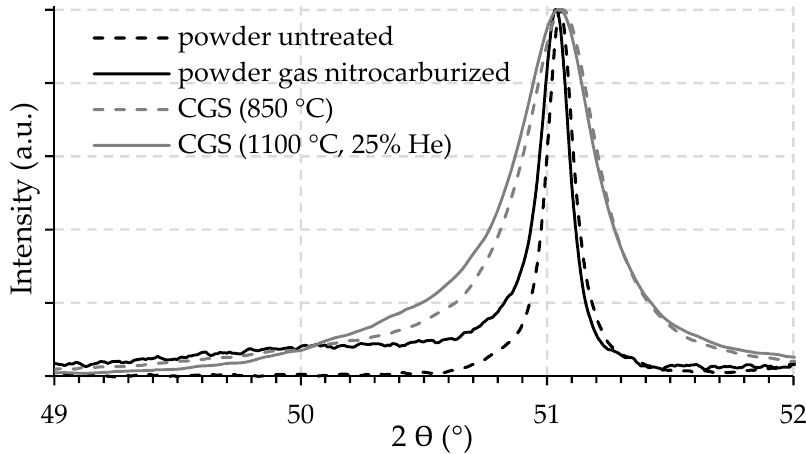
Figure 4. Sections of diffractograms of the untreated and gas-nitrocarburized AISI 316L powders